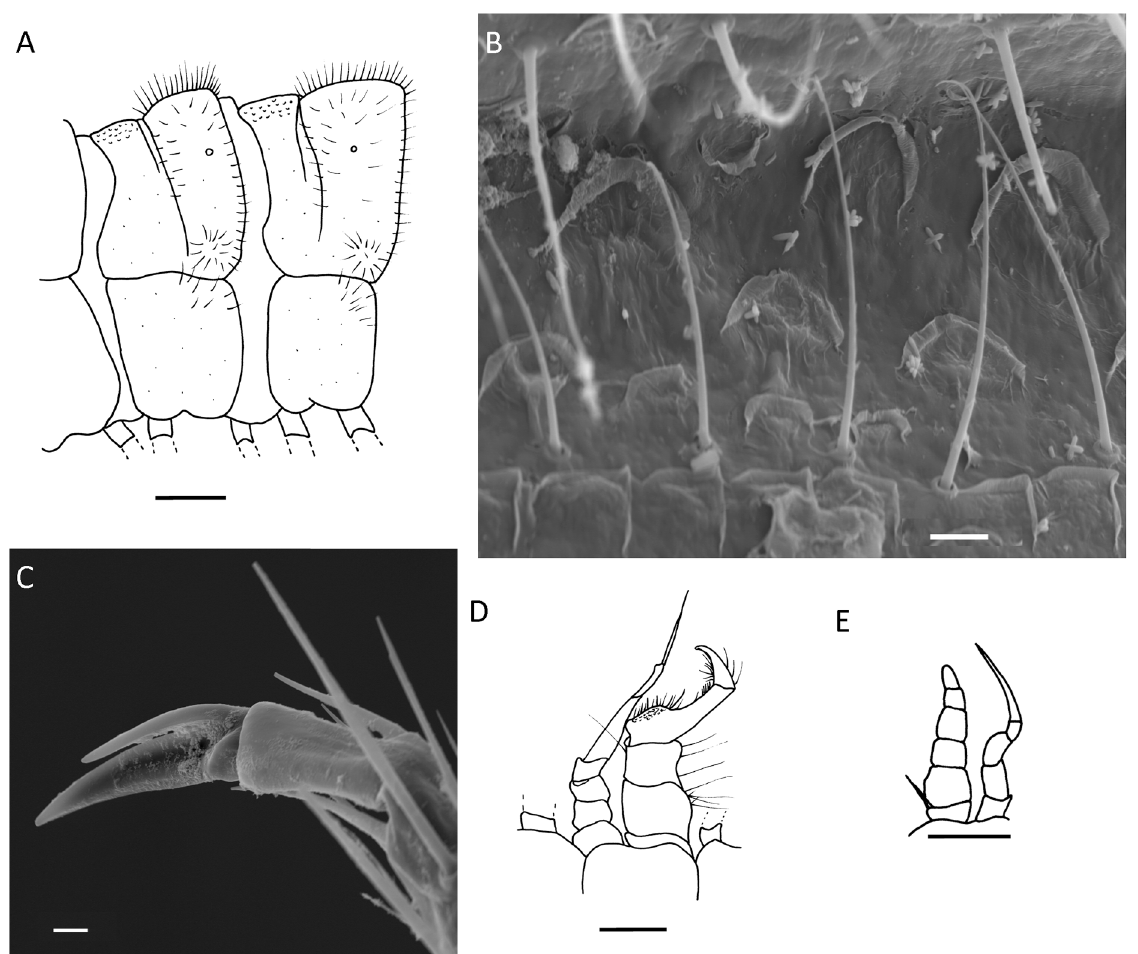
Fig. 5. Columbianum nahvalr sp. nov. A . Midbody rings from lateral view, showing pronounced difference between pro- and metazonite and shape of pleurites. B . ‘Channel’ between pro- and metazonite in dorsal view of male showing tubercles and line of setae . C . Tarsal claw and accessory claw of midbody leg from right side of male, in anterior dorsal view. D . gonopods of holotype male, lateral view with anterior gonopods to right. E . gonopods of small, presumably immature male, in lateral view, anterior gonopds to left. Scale bars = A, D–E = 0.2 mm; B–C = 0.01